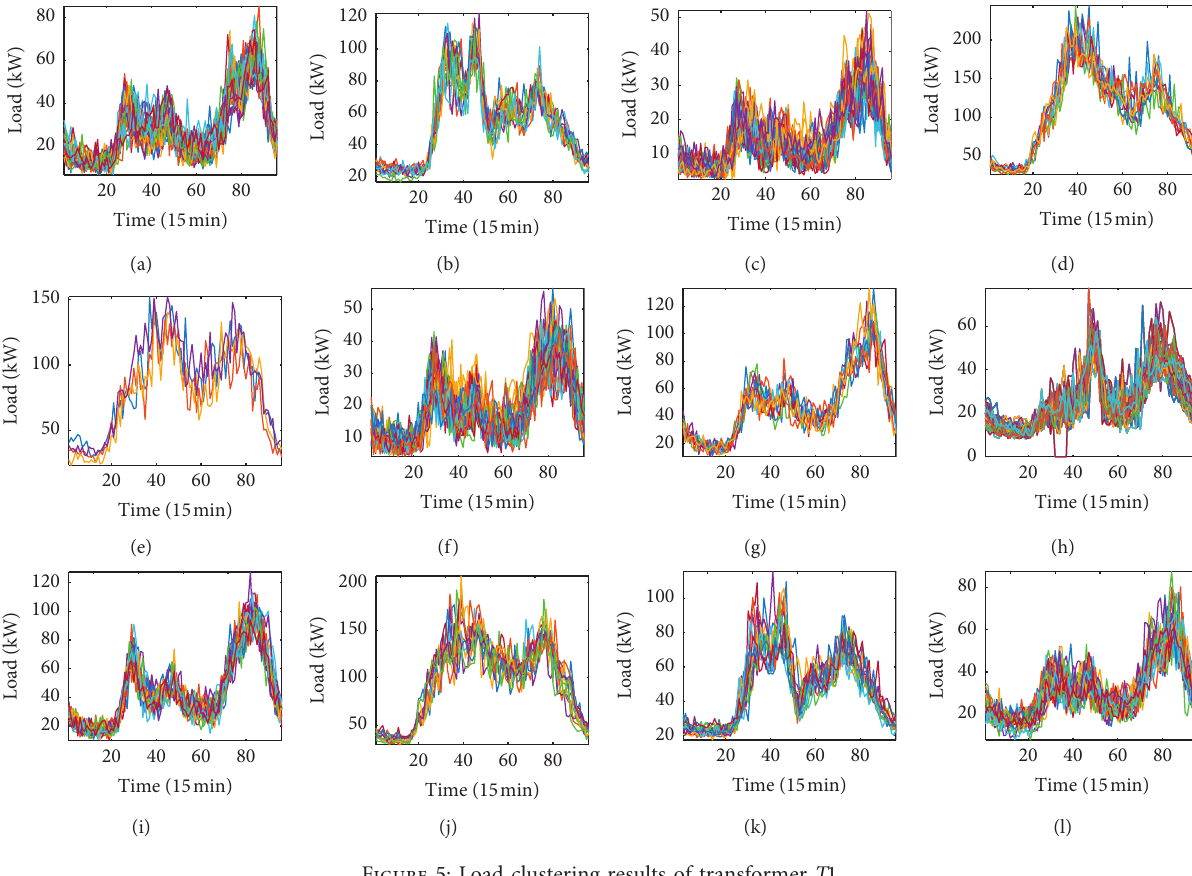
Figure 5: Load clustering results of transformer T 1.